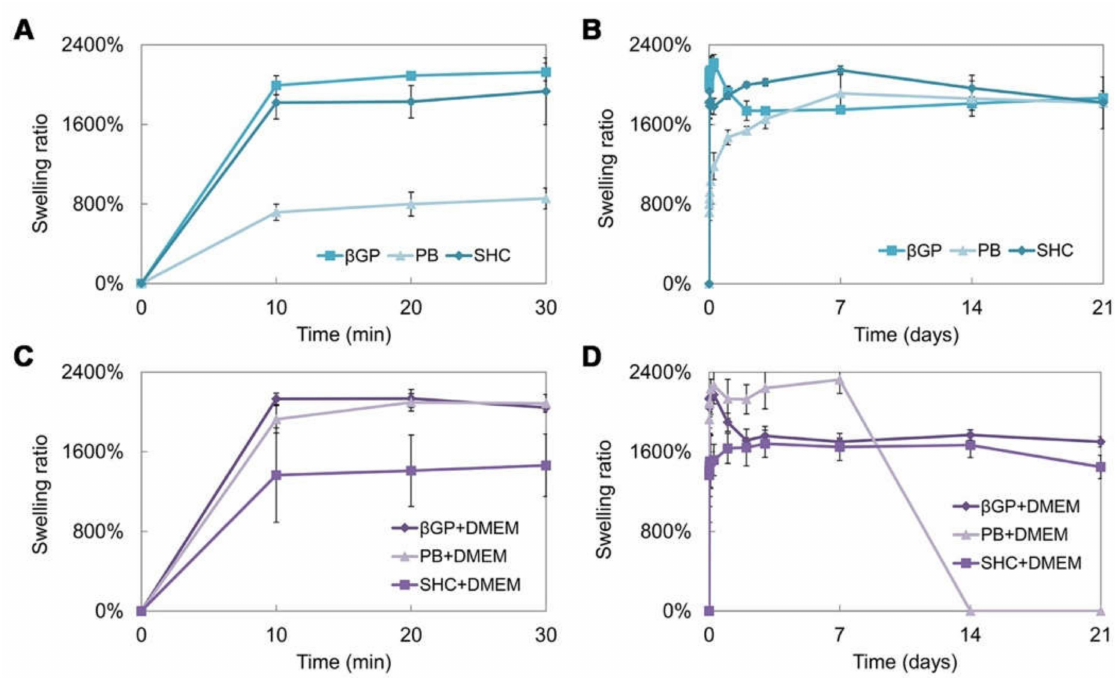
Figure 4. Swelling ratio of the three hydrogel formulations ( β GP, PB, SHC) without DMEM in the first 30 min ( A ) and after 21 days of incubation in PBS at 37 ◦ C ( B ), and with DMEM in the first 30 min ( C ) and after 21 days of incubation in PBS at 37 ◦ C ( D ).